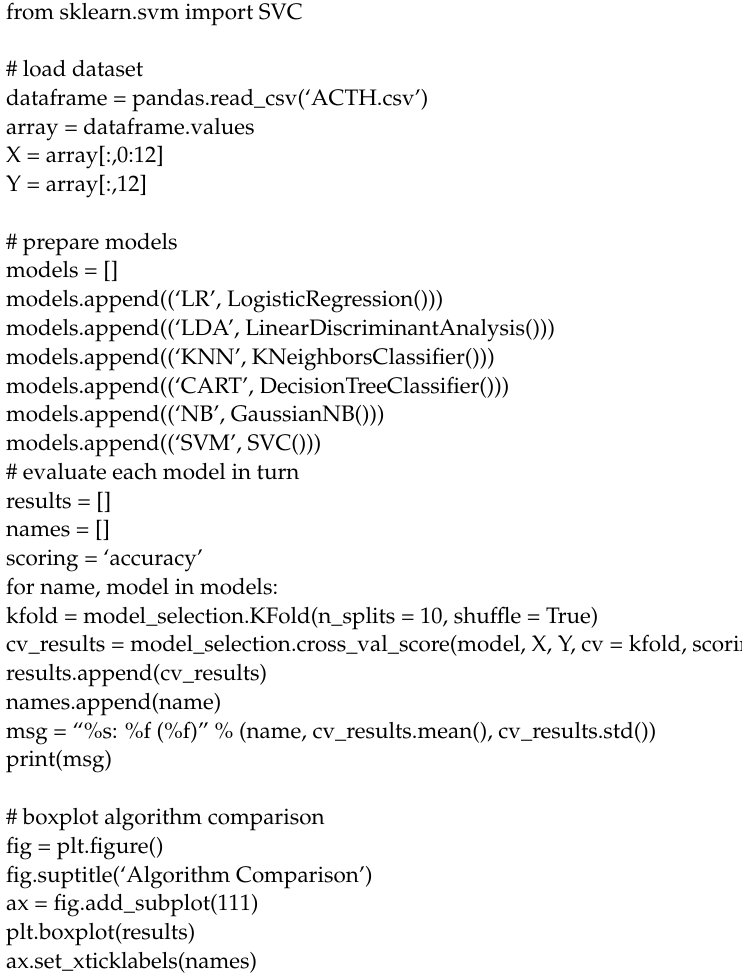
fig.suptitle(‘Algorithm Comparison’)